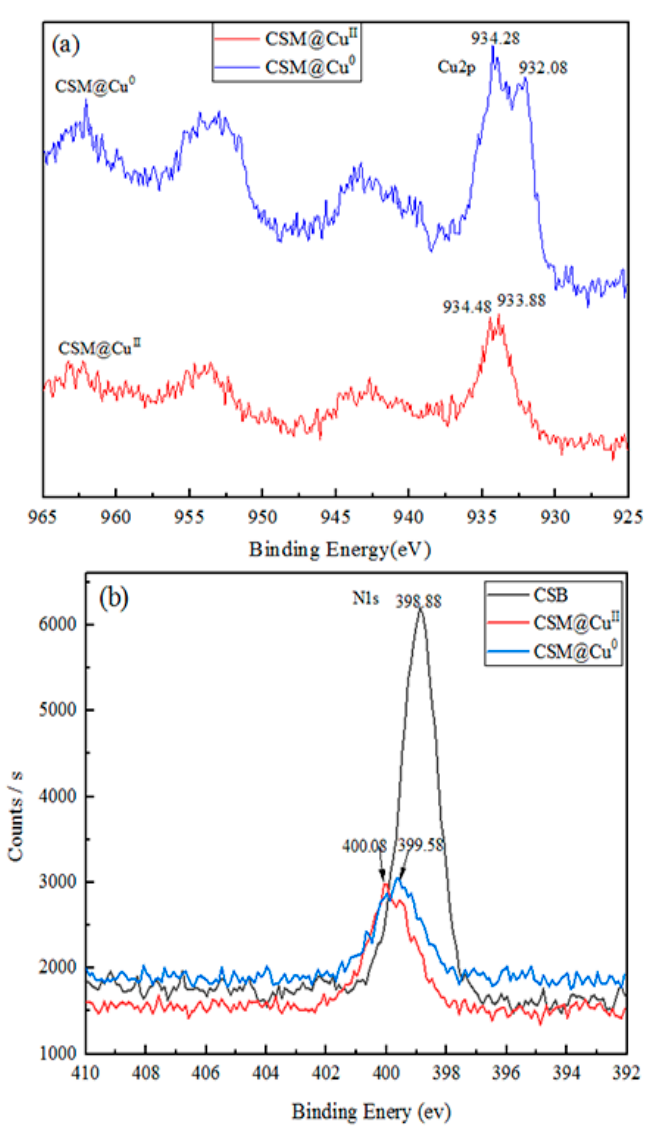
Figure 6. ( a ) X-ray Photoelectron Spectroscopy (XPS) analysis of elemental Cu on Cu 2 + -loaded modified chitosan microspheres (CSM@ Cu II ) and Cu-loaded modified chitosan microspheres (CSM@ Cu 0 ). ( b ) XPS analysis of elemental N on modified chitosan microspheres (CSM), CSM@ Cu II , and CSM@ Cu 0